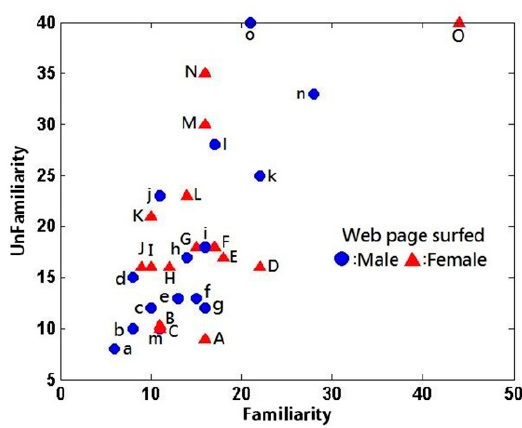
Figure 4. Number of product web pages surfed (familiarity vs. unfamiliarity).